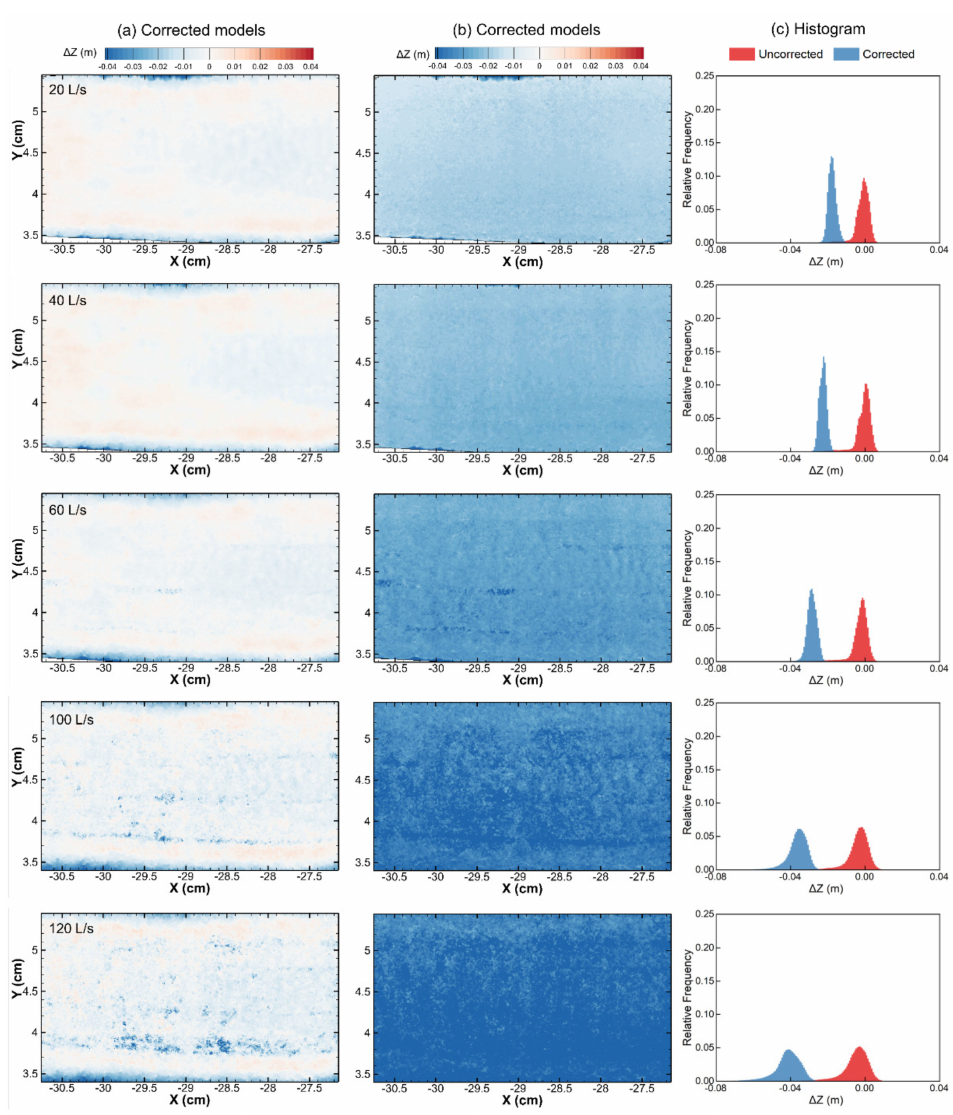
Figure 6. The contours and histograms of elevation errors for the through-water SfM models using the bed GCPs for MR1: ( a ) uncorrected models; ( b ) corrected models; ( c ) histograms. Flow goes from the left to the